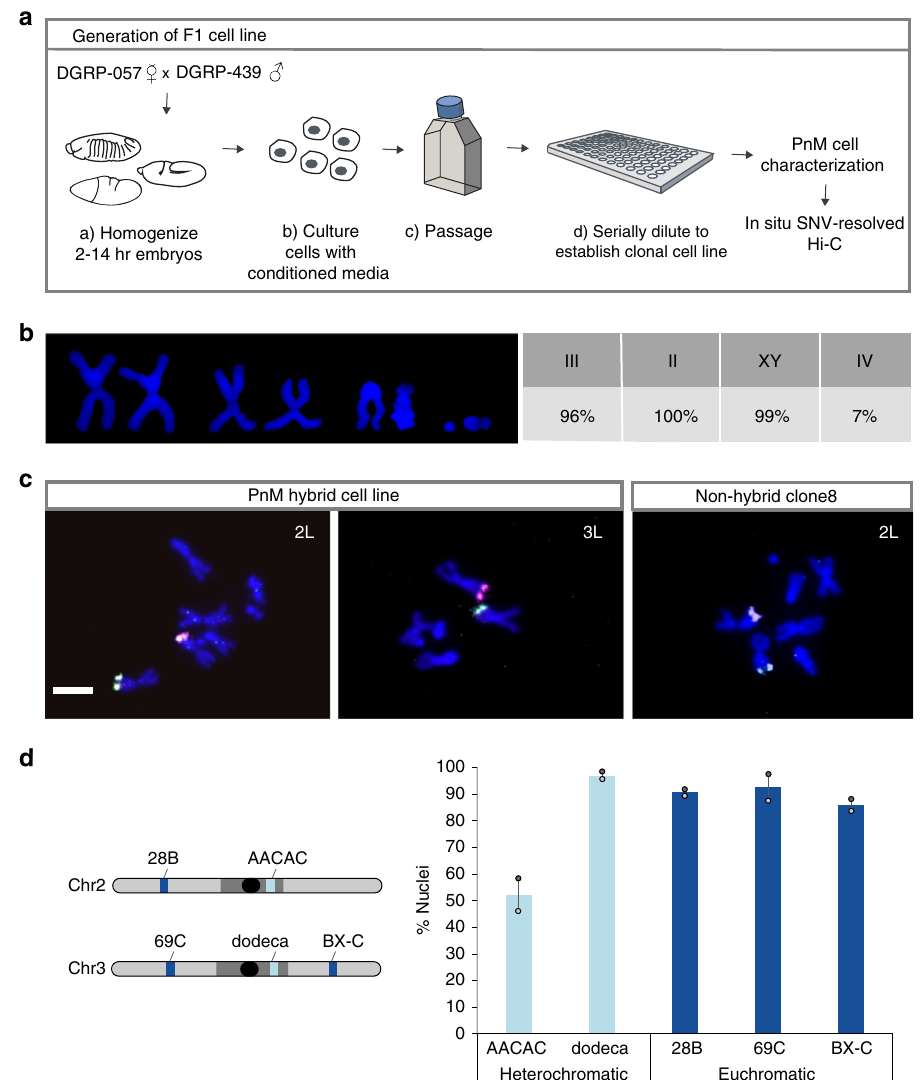
Fig. 1 PnM cell line characterization. a Generation of the cell line. b Karyotyping demonstrates PnM cells to be male and diploid ( N = 50). c Homolog- speci fi c probes (HOPs) distinguishing 057-derived (magenta) from 439-drived (green) homologs for chromosomes (Chr) 2 and 3 on metaphase spreads for PnM and control (non-hybrid) clone8 cells con fi rmed PnM to be hybrid. Scale bar = 5 μ m. d Left: Locations of heterochromatic (light blue) and euchromatic (dark blue) chromosomal regions targeted by FISH. Oval, centromere. Right: Levels of pairing in PnM cells quanti fi ed as percent of nuclei in which FISH signals, representing allelic regions, co-localized (center-to-center distance between signals ≤ 0.8 μ m; error bars, s.d. for two biological replicates; N > 100 nuclei/replicate). Source data are provided as a Source Data fi